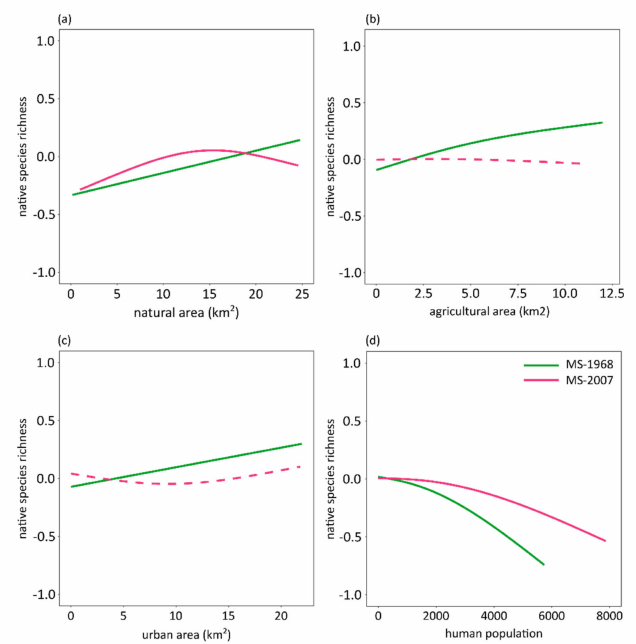
Figure 3. E ff ect plots showing results of Generalized Additive Models using as response variable the alien species richness of breeding birds of Massachusetts, and as predictors, native species richness ( a ), area of di ff erent land uses (natural, agricultural, urban; b – d ), and human population ( e ) for the first (MS-1968, green lines) and the second time period (MS-2007, red lines), after accounting for spatial autocorrelation. All predictors entered model as smooth functions; thus, y-axis presents mean-centered alien species richness summing up to zero. Significant relationships depicted with solid lines; dashed lines denote non-significant relationships.